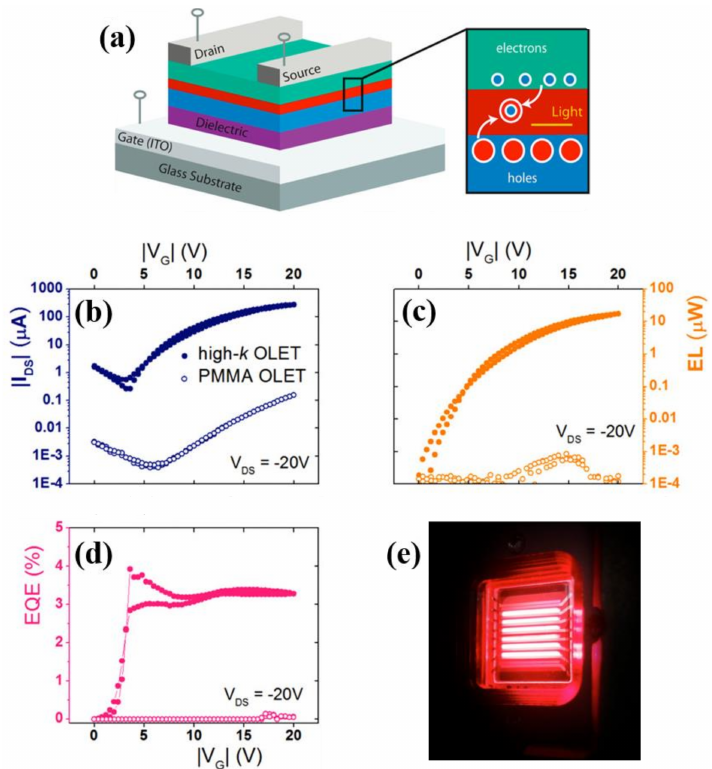
Figure 9. Organic light emitting transistor using high- k polymer dielectric layer. ( a ) Schematic representation of the tri-layer OLET, where the dielectric layer is either PMMA or high- k polymer P(VDF-TrFE-CFE). ( b ) Drain-source current, ( c ) electroluminescence and ( d ) EQE curves of PMMA- and high- k OLETs in the limit of V D = − 20 V. ( e ) Optical image of the red OLET in its ON state. Reproduced from [104], © (2017) American Chemical